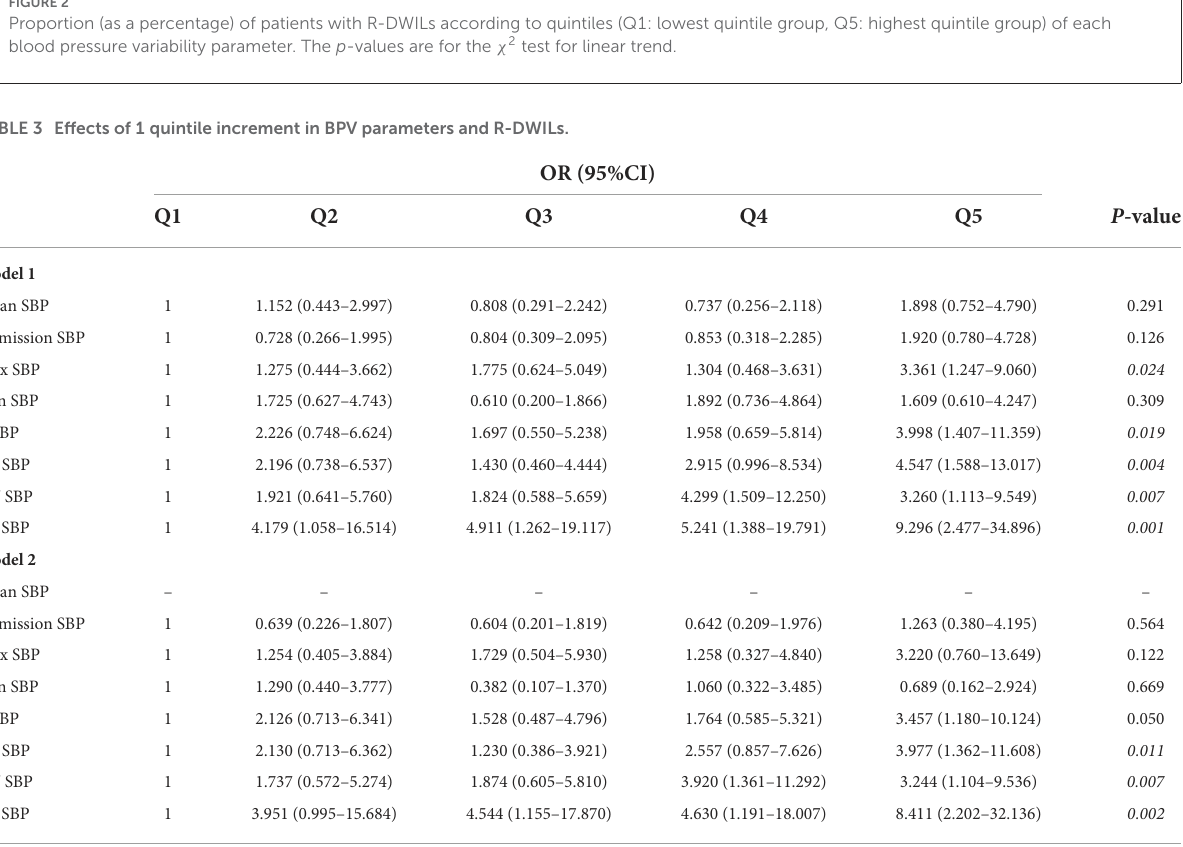
TABLE 3 Effects of 1 quintile increment in BPV parameters and R-DWILs.